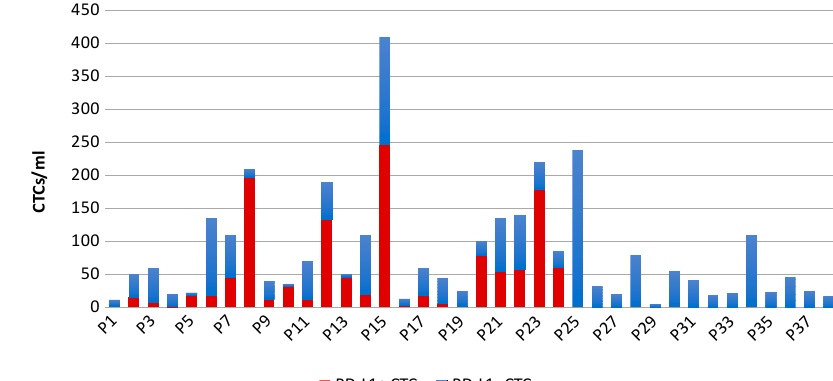
Figure 2. Representative images of CTCs detected and subjected to immunostaining with DAPI, CD45, Pankeratins and PD-L1. Example images of CTCs from a patient with PD-L1 − CTCs ( A ) and PD-L1 + CTCs ( B ) are shown. The scale bar of 10 μ m was applied to all pictures. ( C ) Number of CTCs and PD-L1 status isolated from blood samples from 38 patients (P1 through P38) with detectable PD-L1 status. “P1” stands for patient 1. Red bar represents the number of CK(+)/PD-L1(+) CTCs. Blue bar represents the number of CK(+)/PD-L1( − ) CTCs.